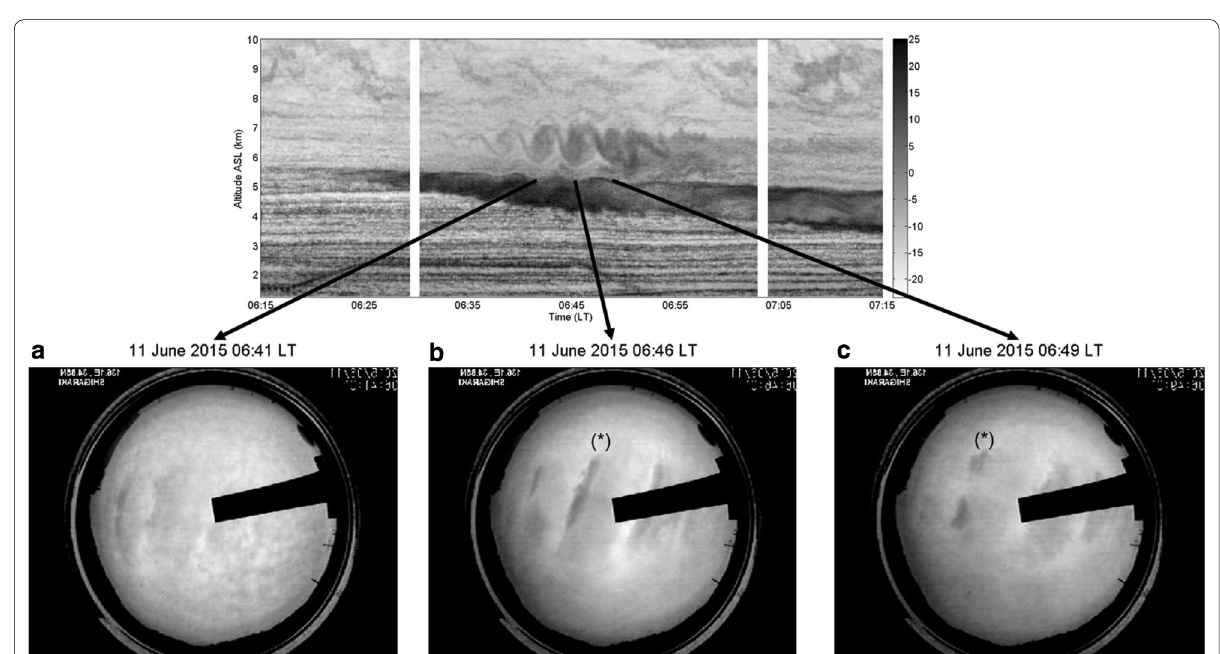
Fig. 11 Photographs of the cloud base taken by the fish-eye camera and its corresponding location in the time–height plot of the radar image at a 0641, b 0646 and c 0649 LT, after the onset of the KH billows. The labels (*) refer to darker bands at some phases of the